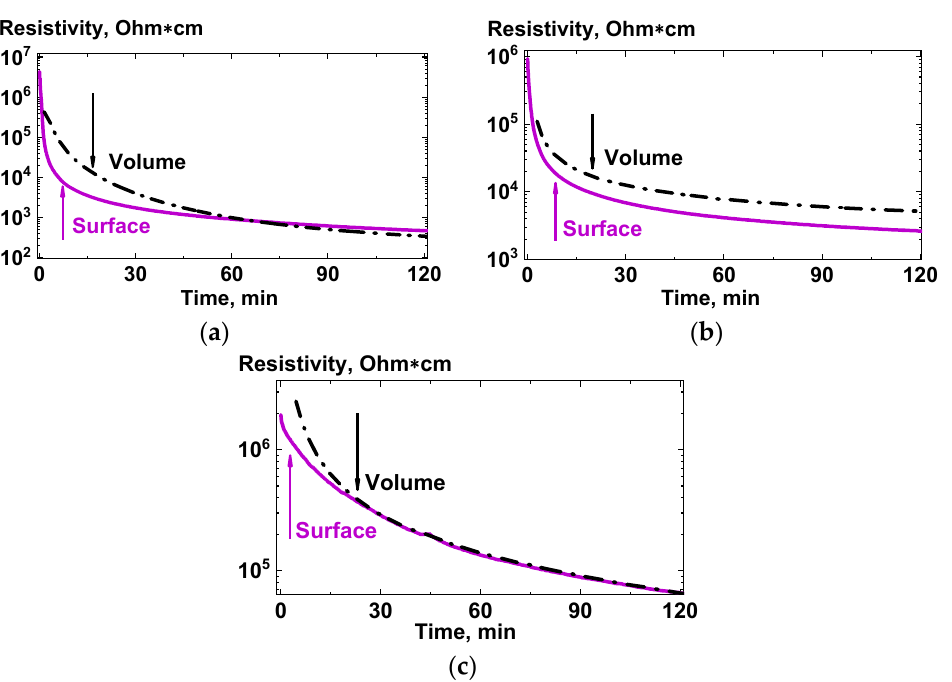
Figure 14. Time dependences of the volume and surface components of the resistivity of PP + 12.5 wt.% CB ( a ), PP + 15 wt.% GnPs ( b ), and PP + 0.5 wt.% SWCNTs ( c ) composites melts. The arrows show the characteristic times for the “fast” regions of the curves.